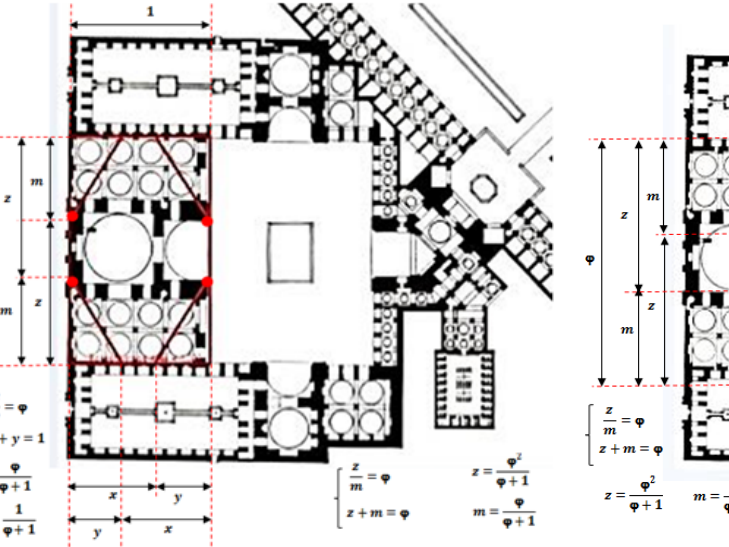
Figure 7: Setting the yard and porches in a golden